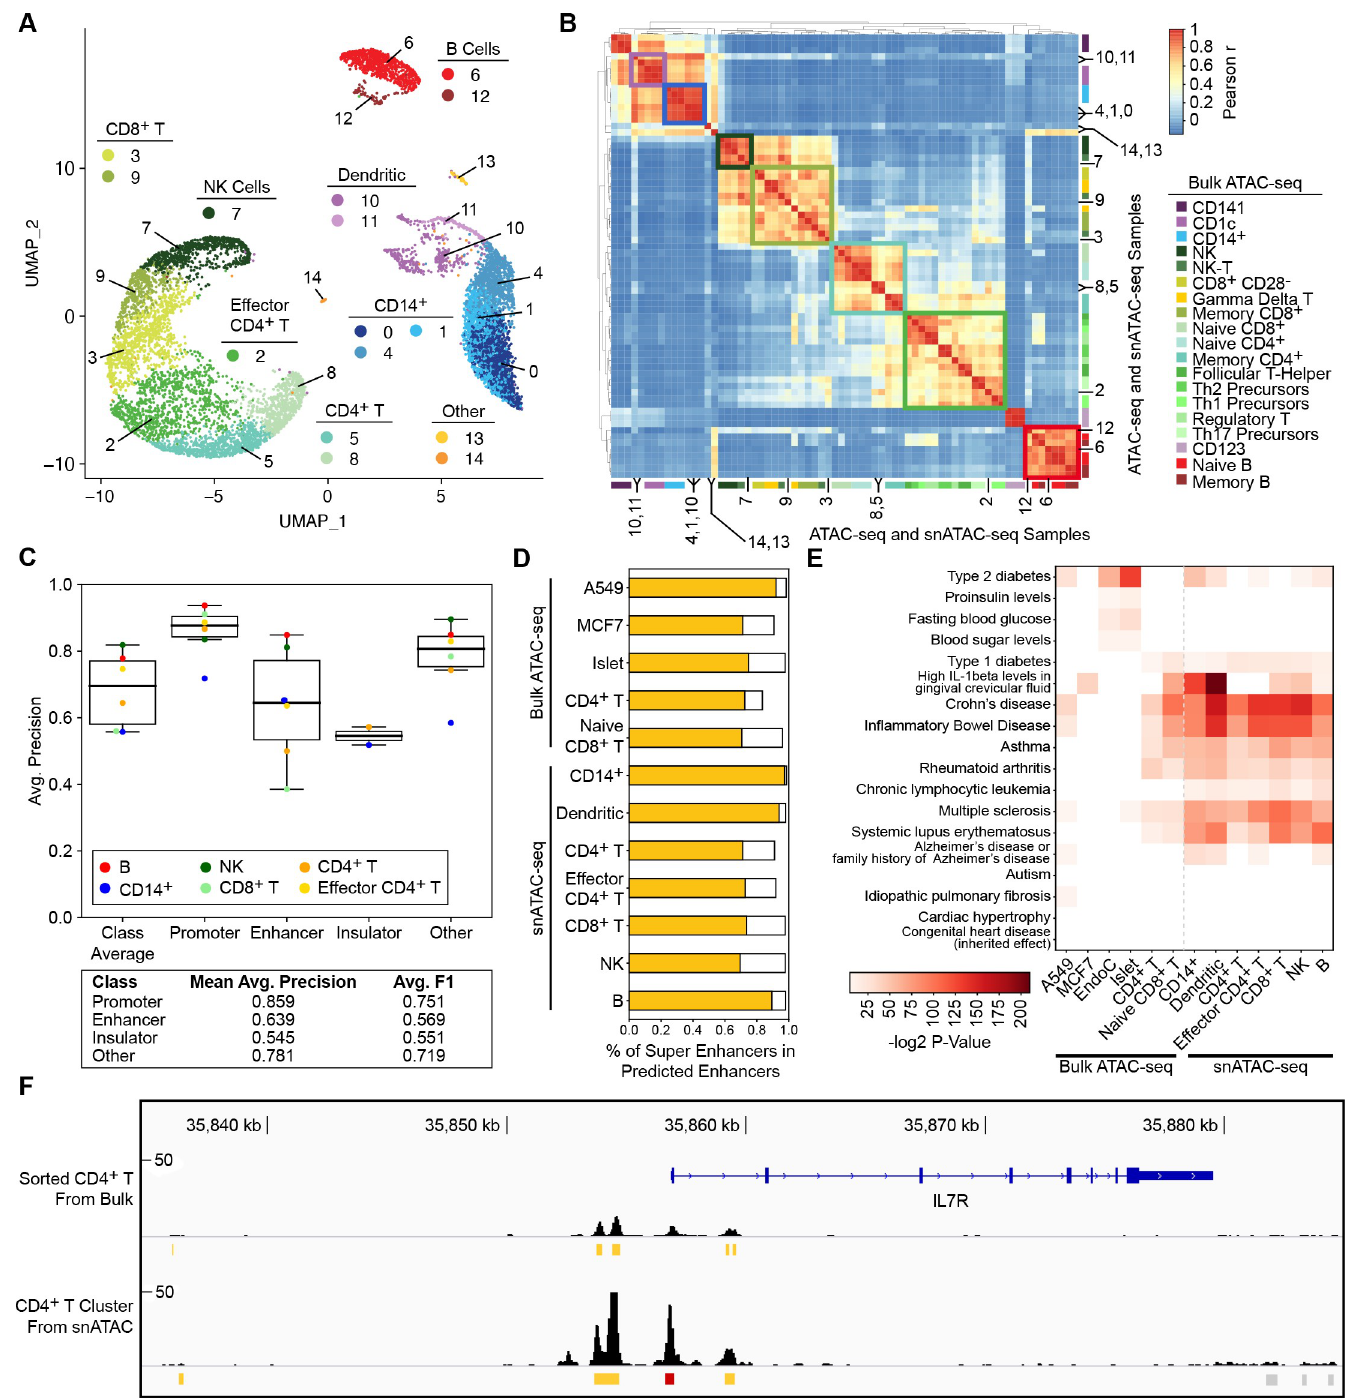
Fig 5. Predicting functionality of REs from clusters of PBMC snATAC-seq data. ( A ) Single cell clusters annotated for 7 immune cell types. Two-pass clustering identified a total of 15 cell clusters which we annotated using hierarchical clustering with sorted bulk ATAC-seq data (shown in ( B )) to identify 7 different immune cells corresponding to these clusters. ( B ) Hierarchical clustering of snATACclusters with bulk ATAC-seq data. Numbers and highlighted regions within the heatmap correspond to cell clusters and annotations in ( A ). 7 immune cell types were observed with both snATAC and bulk ATAC-seq samples. ( C ) (Top) Average precision values for predicting cis -RE function in snATAC for 6 annotated clusters with available ChromHMM states. Model performances suggest that CoRE-ATAC is an effective tool for interrogating cis -RE activity from snATAC data. (Bottom) Mean average precision and average F1 score values for promoters, enhancers, insulators and other. ( D ) Percent of super enhancers detected among CoRE-ATAC enhancers, demonstratingCoRE-ATAC’s ability to identify cell-type-specific enhancers that are